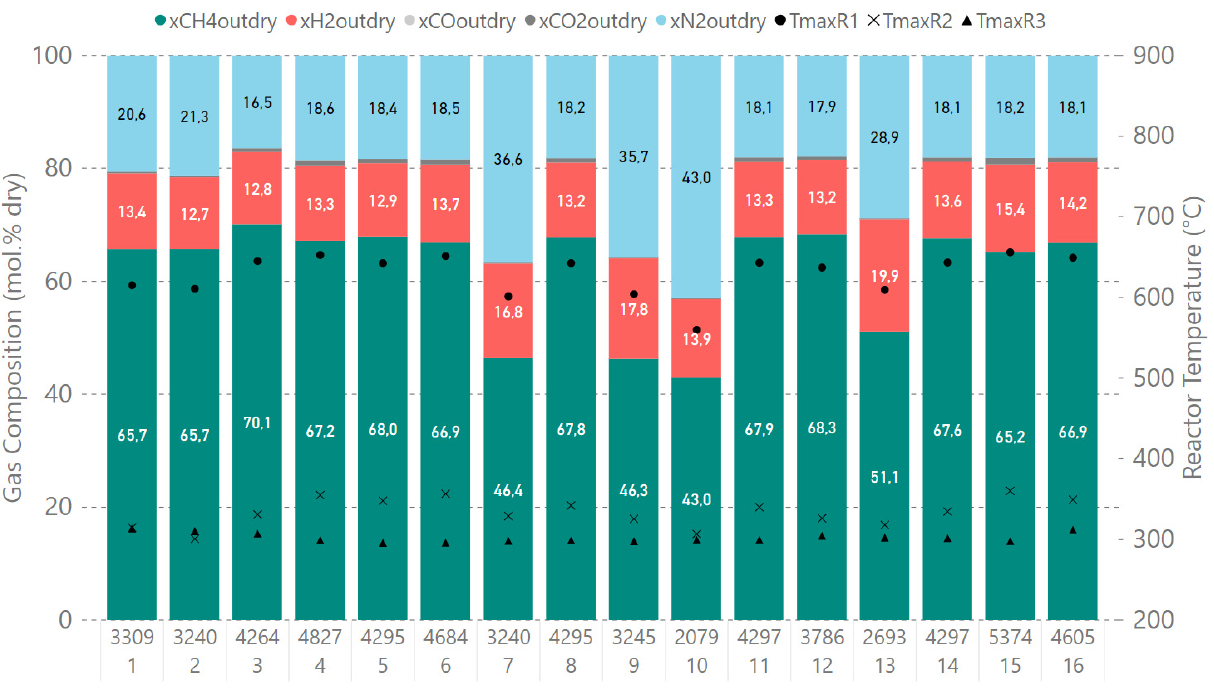
Figure 20. SC1. Product gas compositions and max. reactor temperatures for 16 representative points in time (values in mol.% (dry) and °C) for MUL_CH4_TR. Table 3. SC1. Operating parameters, product gas compositions, and CO x conversion ( X COx ) rates for 16 representative dynamic operating points for MUL_CH4_TR. BFG disturbances are highlighted with *. SN CH4 = 1.04 for all reference points.